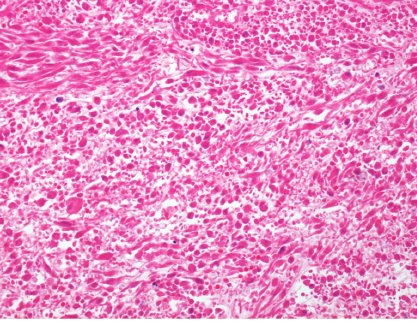
Figure 2: H&E section shows cellular smooth muscle tumor with nuclear pleomorphism.